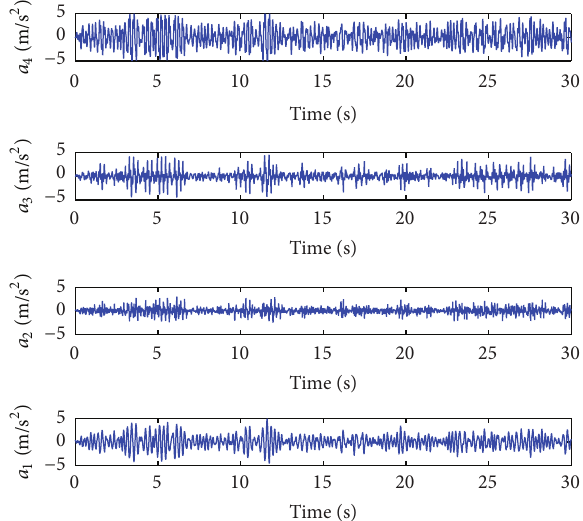
Figure 7: Measured acceleration responses for Case